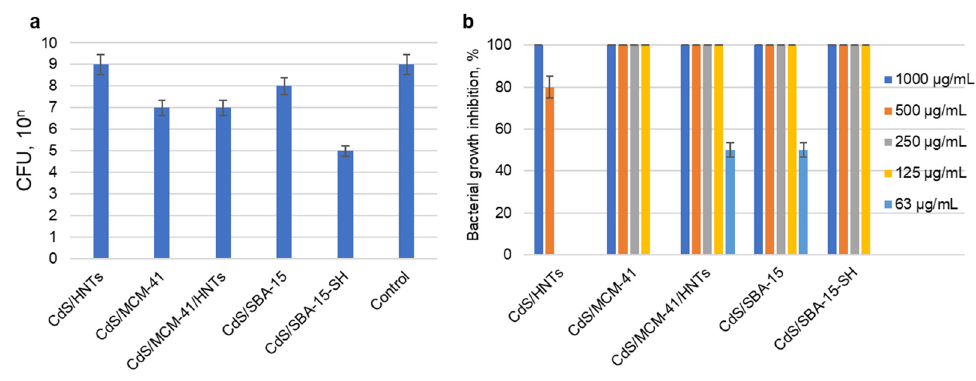
Figure 6. Antibacterial activity of CdS nanocomposites against S. aureus : in the dark (concentration of composite 1000 μ g/mL) ( a ); under visible light irradiation depending on the concentration of composite (63–1000 μ g/mL) ( b ).